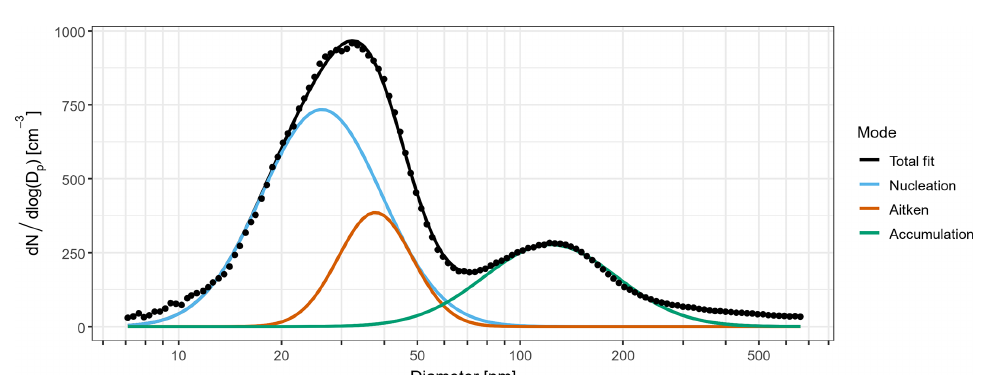
Figure 3. Mean number size distribution for sub-micron aerosol during periods of mSO air masses. The coloured lines are fitted log-normal distributions representing contributions from nucleation (blue), Aitken (brown), and accumulation (green) mode aerosol to the observed total size distribution (black